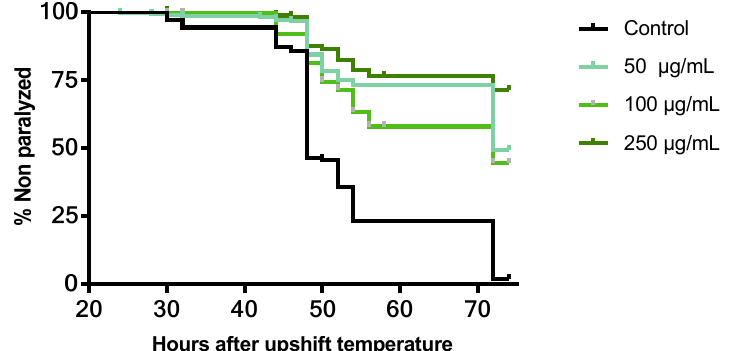
Figure 6. Effect of B. officinalis flower extract on A β -induced paralysis on transgenic C. elegans CL4176. The PT50 were 48 h for the control group and 72 h for 50 and 100 µg/mL treated group. The PT50 was not achieved in the group treated with 250 µg/mL. Statistical significance of the difference between the experiments was analyzed by a log-rank (Kaplan–Meier) statistical test, which compared the survival distributions between the control and treated groups. Differences in survival tests between treatment and the control group were p ≤